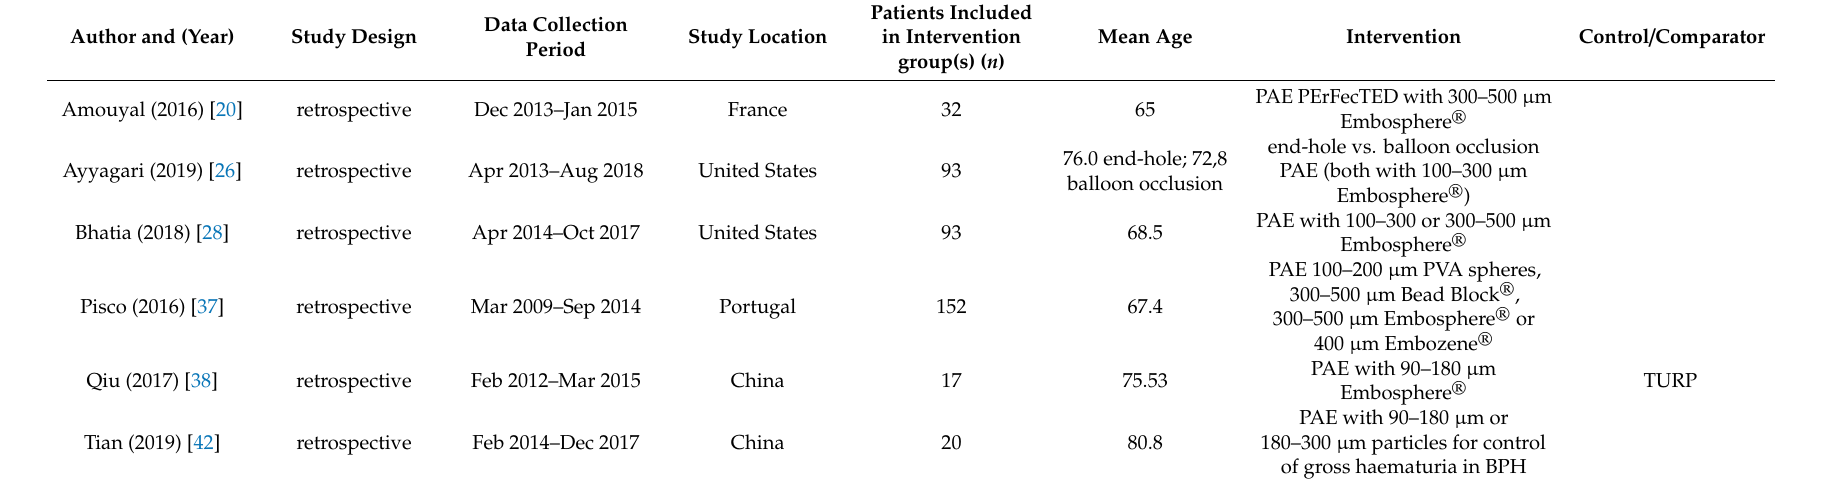
Table 3. Study characteristics of retrospective